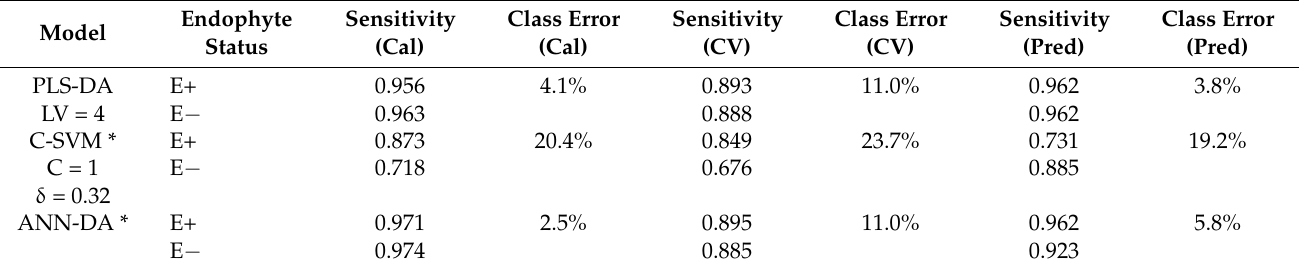
Table 3. Classification models using full spectra for E+ ( n = 551) and E − ( n = 454) calibration dataset and E+ ( n = 26) and E − ( n = 26) prediction